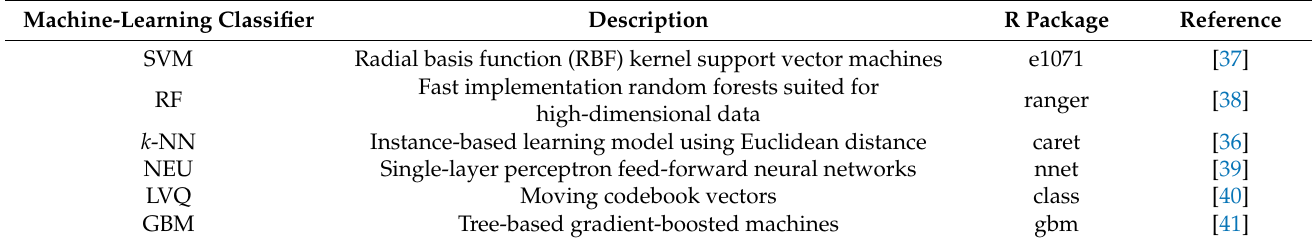
Table 4. List of supervised classification methods and associated R